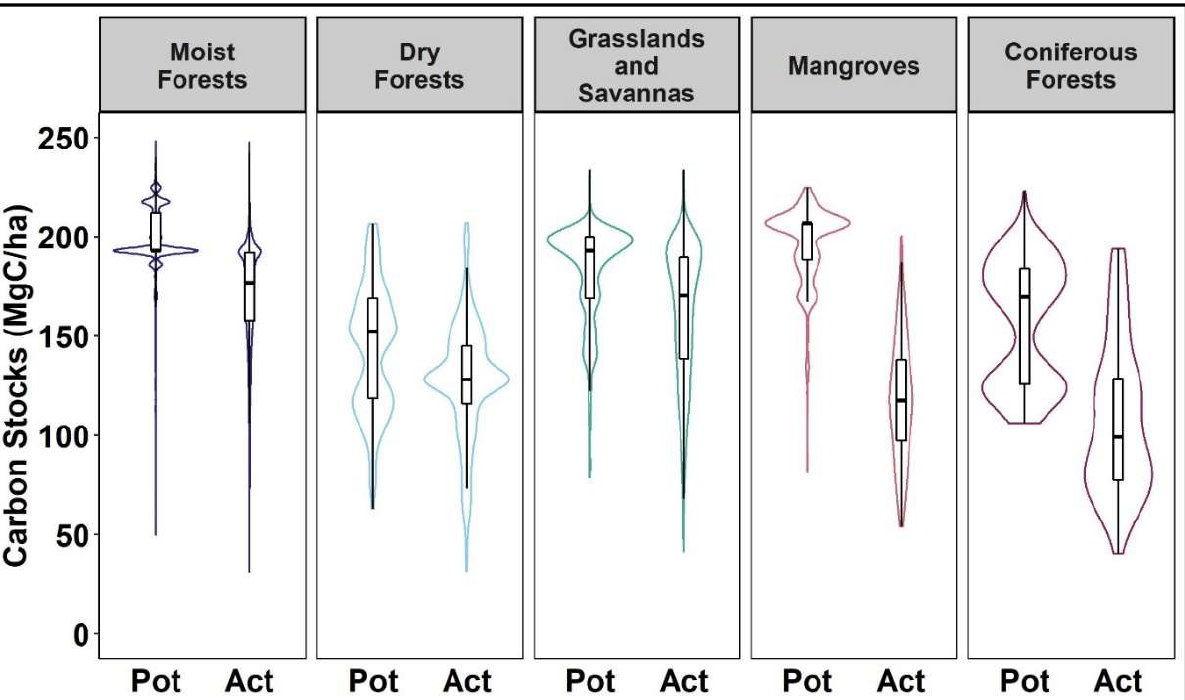
Figure 5. Distribution of biomass carbon stocks densities in tropical biomes with high TC densities in potential (‘Pot’) and actual (‘Act’) vegetation. Here, ‘Pot’ denotes potential vegetation; ‘Act’ denotes actual vegetation. The figure refers only to individual pixels with median actual TC > 90%. We selected biomes where no. of pixels per biome, n > 50. Other tropical biomes were excluded due to a lack of pixels fulfilling this selection criterion. The distribution of the peaks of the violin plot depicts the probability density of individual pixels in the given biome. Corresponding median maps for potential CS, actual CS actual TC are used here (for sources see Materials and Methods Section).